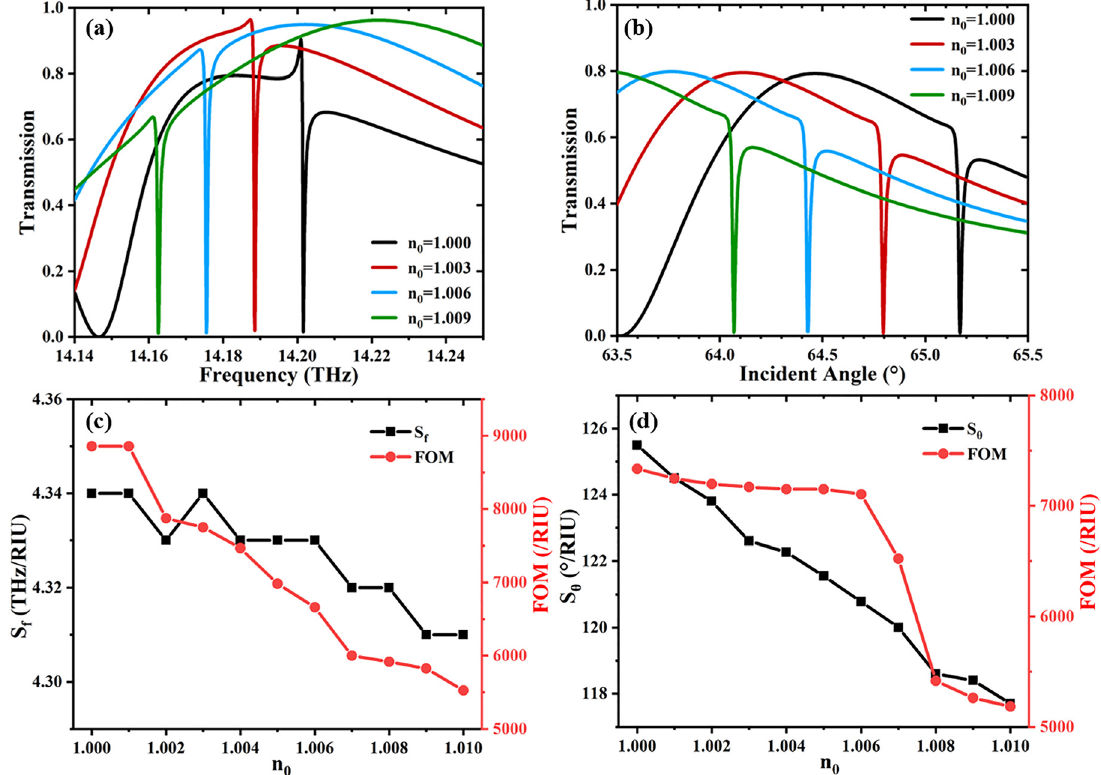
Figure 5: Numerical performance of THz sensor in the frequency and angle domains. (a) and (b) show the variation of transmittance in frequency and angular spectra, respectively, for a varied refractive index of the gaseous analyte: n 0 = 1.000, 1.003, 1.006, and 1.009. (c) and (d) reveal the sensitivity and fi gure of merit (FOM) of the Fano mode, respectively, with different refractive indexes arising from 1.00 to